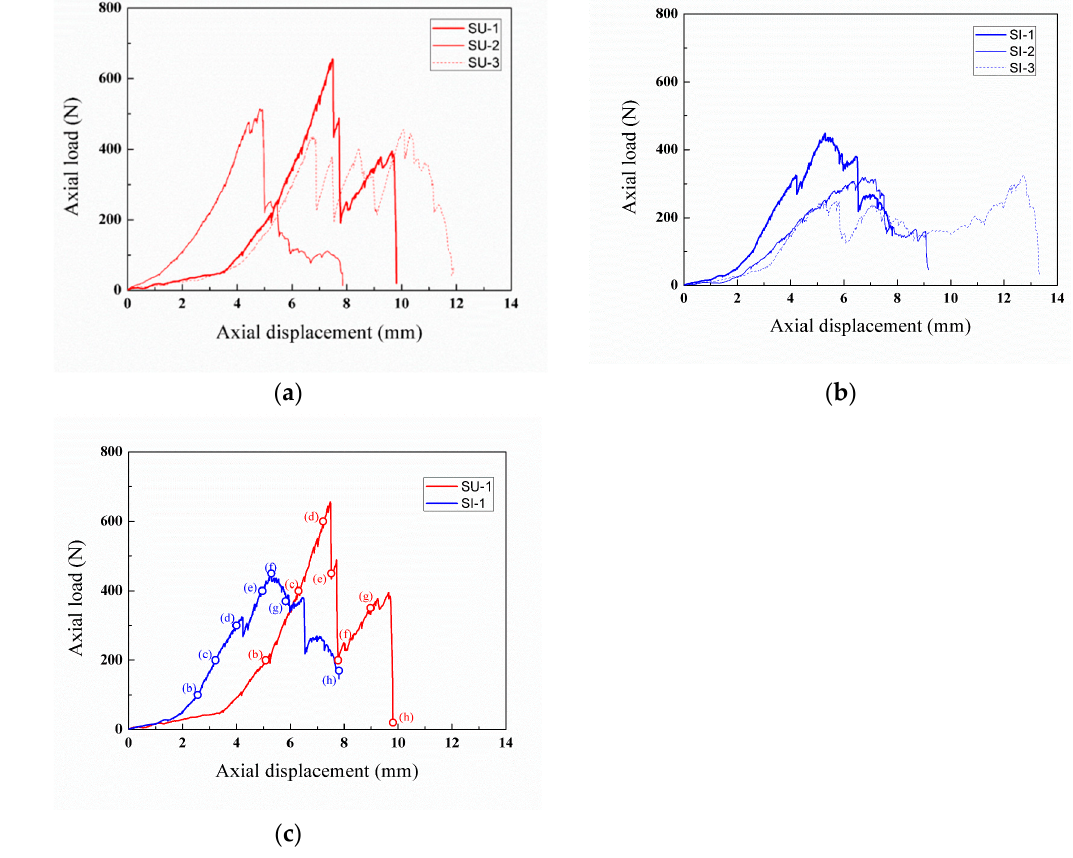
Figure 10. Load–displacement curves for SU and SI under shallow foundation loading: ( a ) uniform structure; ( b ) structure with imperfections; ( c ) selected data for comparison.